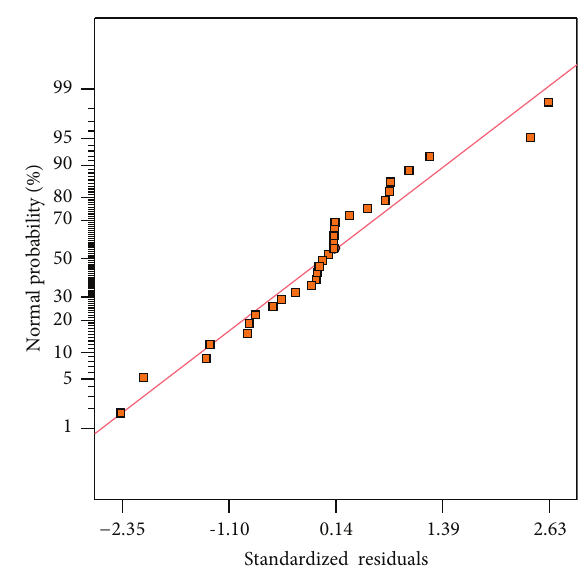
Figure 3: Normal probability plot of the